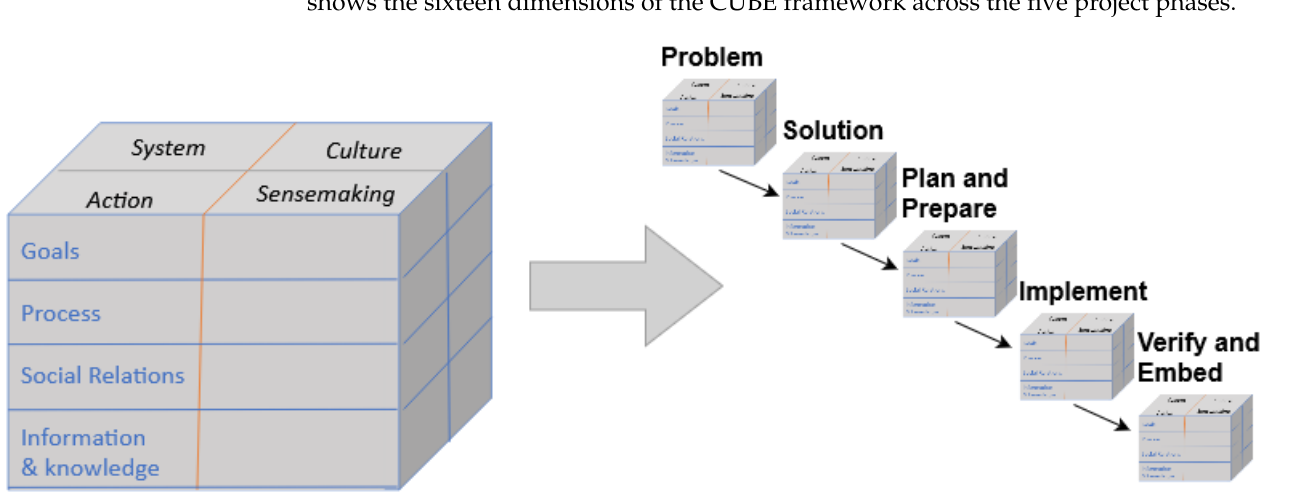
Figure 1. Dimensions of the CUBE.